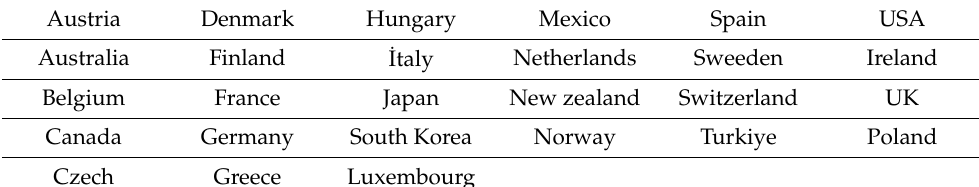
Table 2. Sample OECD countries used in this